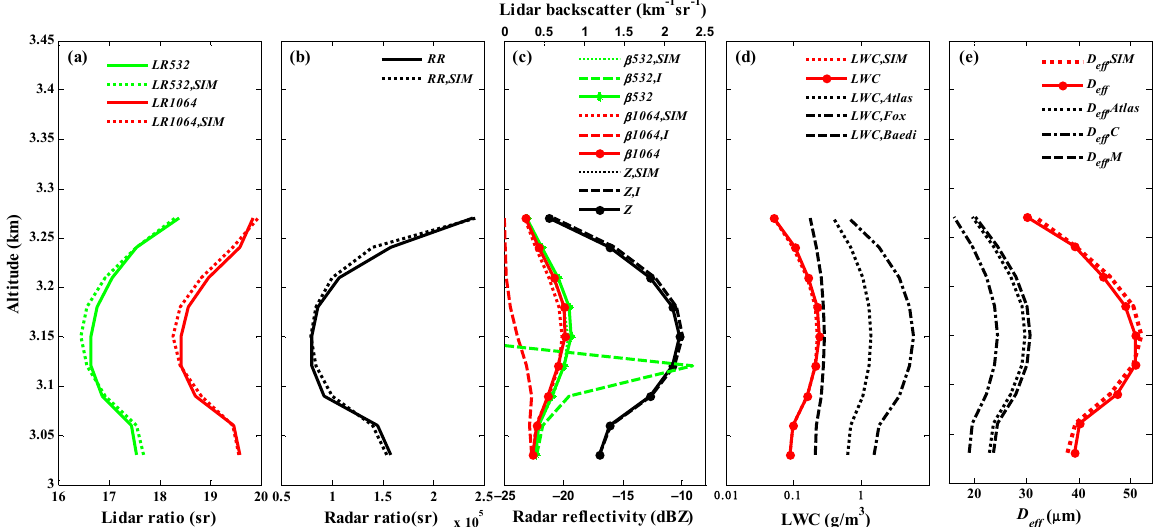
Figure 8. Comparison of the iteration results (solid line) with the simulation (SIM, dot line) in profile. The DSD parameter was the same as in Figure 6b: ( a ) lidar ratio at different wavelengths ( LR 532 , LR 1064 ); ( b ) radar ratio ( RR ); ( c ) lidar backscatter at different wavelengths ( β 532 , β 1064 ) and radar reflectivity factor ( Z ) (initial value subscript I , dash line); the β 532 , SIM was superimposed in β 532 ( d ) liquid water content (LWC); ( e ) effective diameter ( D eff ) .